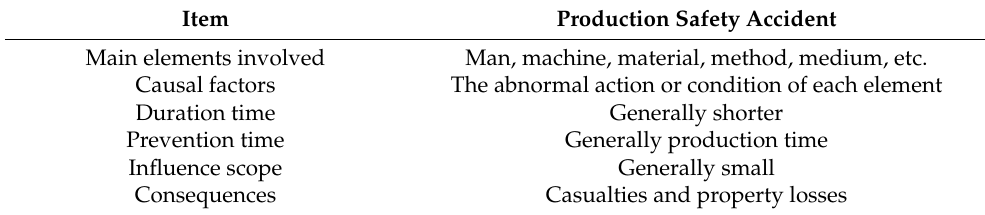
Table 4. Main parameters of various production safety accidents.